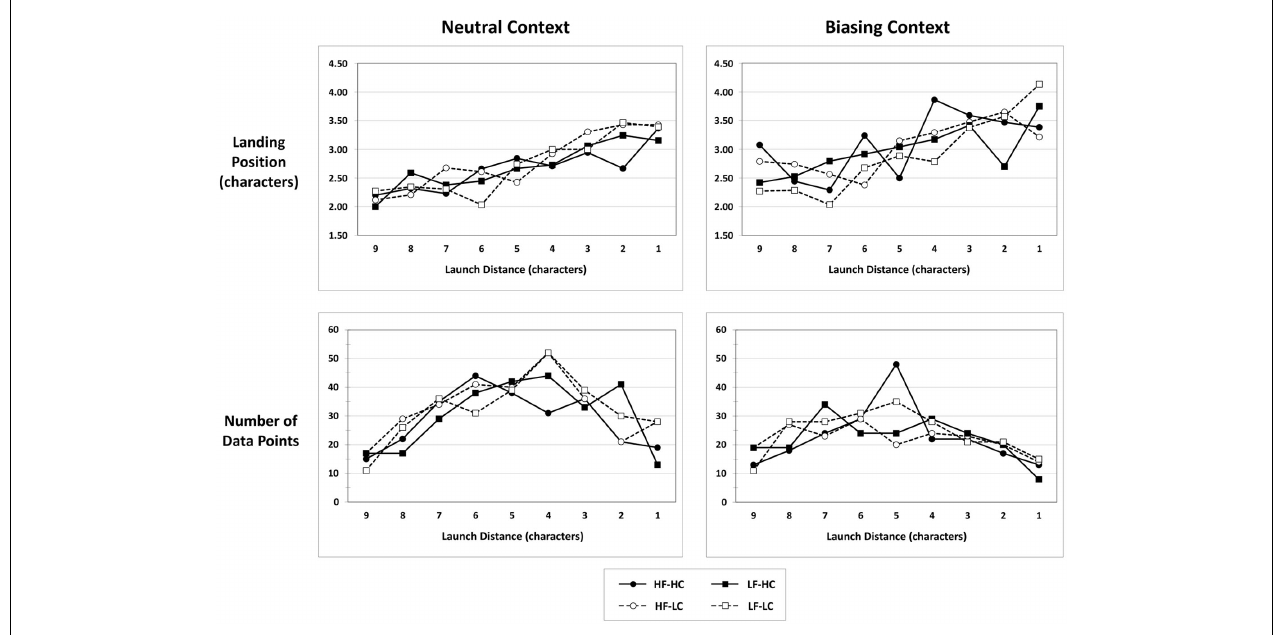
FIGURE 3 |Target landing position (characters) and number of data points as a function of launch distance (characters) from the target for